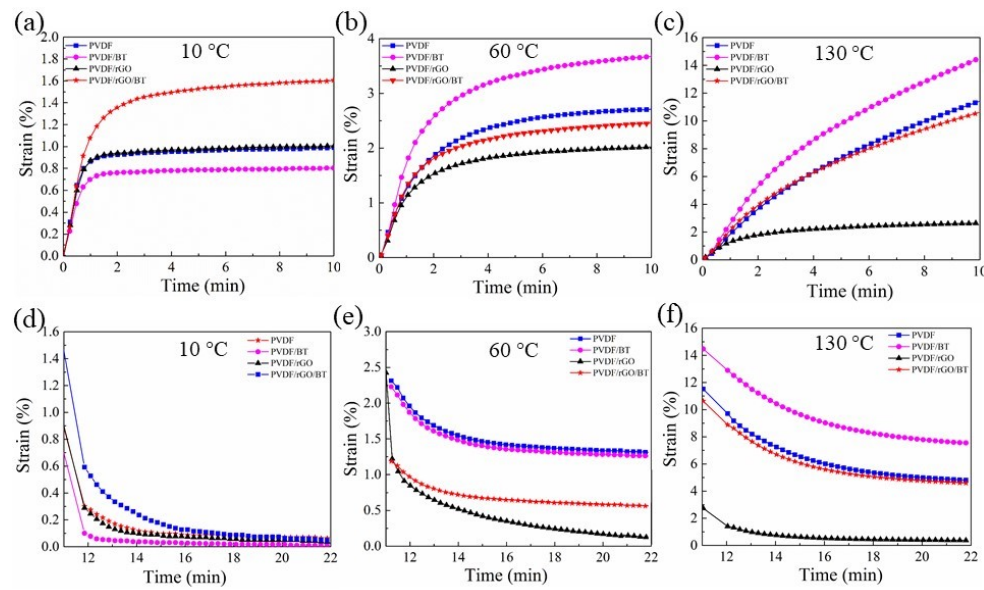
Figure 7. The creep behaviours ( a – c ) and creep recovery ( d – f ) of the melt-spun PVDF, PVDF/BT, PVDF/rGO, and PVDF/rGO/BT fibers at temperature (10, 60, 130 °C).